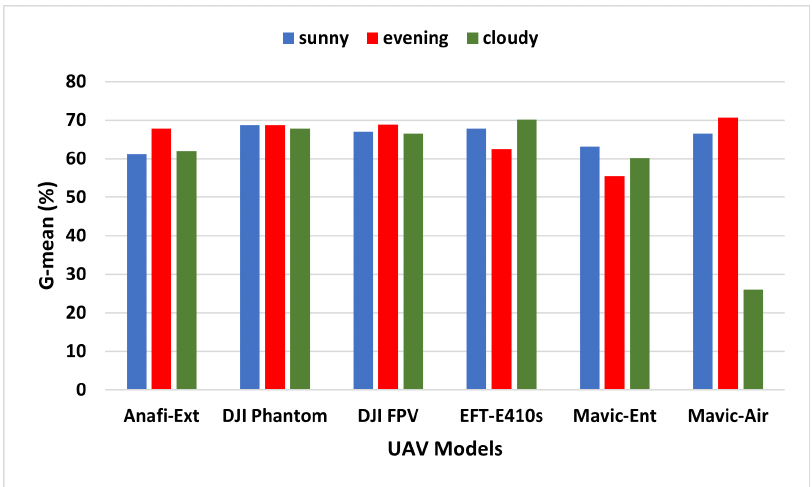
Figure 11. G-mean graph of ALIEN performance showing the trade-off between R + c and R − c in detecting different UAVs across all scenarios.